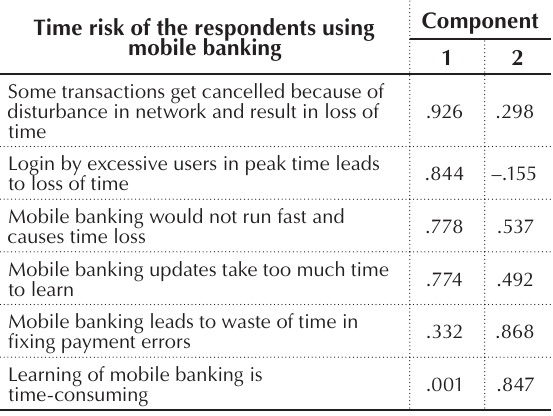
Table 8. (cid:38)(cid:258)(cid:272)(cid:410)(cid:381)(cid:396)(cid:3)(cid:258)(cid:374)(cid:258)(cid:367)(cid:455)(cid:400)(cid:349)(cid:400)(cid:3)(cid:381)(cid:374)(cid:3)(cid:410)(cid:346)(cid:286)(cid:3)(cid:415)(cid:373)(cid:286)(cid:3)(cid:396)(cid:349)(cid:400)(cid:364)(cid:3)(cid:3)